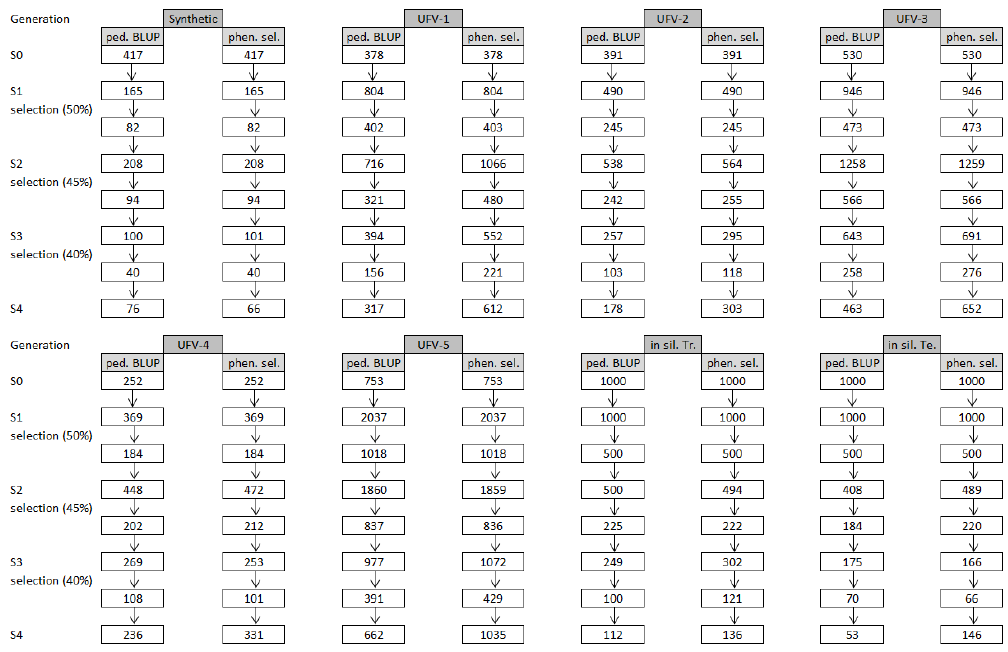
Figure 1. Sample size and number of selected plants in S 1 , S 2 , and S 3 generations, in each popcorn and in silico populations, under pedigree-based BLUP and phenotypic mass selection. and in silico populations, under pedigree-based BLUP and phenotypic mass